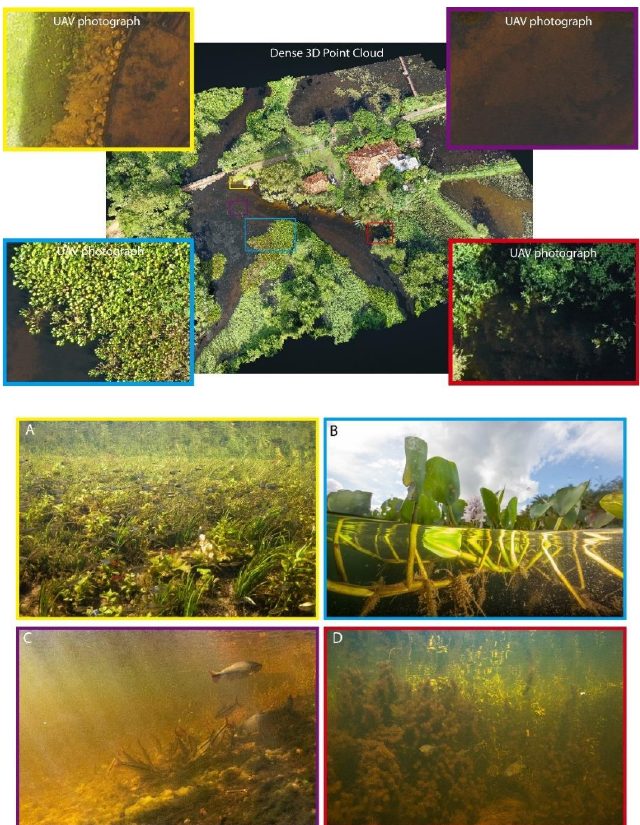
Figure 14. Dense 3D point cloud from the Salobra river, Mato Grosso do Sul, Brazil generated through a Structure-from-Motion Multiview Stereo workflow from 768 UAV photographs. Photographs were acquired with a DJI Mavic 2 Pro UAV with an integrated Hasselblad L1D-2C camera. The camera has a 1” sensor (77 ◦ field of view) producing an image size of 5472 × 3648 pixels. A median of 67,753 key points were found per photograph with a median of 13,416 matches per photograph. Final ground sampling distance of the model is 1.2 cm. Extensive floating water hyacinth ( Eichhornia crassipes ) can be seen. The interactive point cloud can be accessed at https://bit.ly/waterhyacinth3D. Panel A (yellow) illustrates a shallow (<30 cm) area with several species of SAV which produce a habitat utilized by small characins. Panel B (blue) illustrates floating E. crassipes in deep (>2 m) water frequented by giant otters ( Pteronura brasiliensis ) and caimans ( Caiman yacare ). Panel C (purple) is a mid-range depth (1–2 m) with large patches of algae on the substrate. This open water habitat is frequented by larger fish species such as Prochilodus lineatus . Panel D (red) shows a bed of Camboba sp. in deep water (>2 m). The dense stems provide habitat for species such as Pygocentrus nattereri and Serrasalmus maculatus